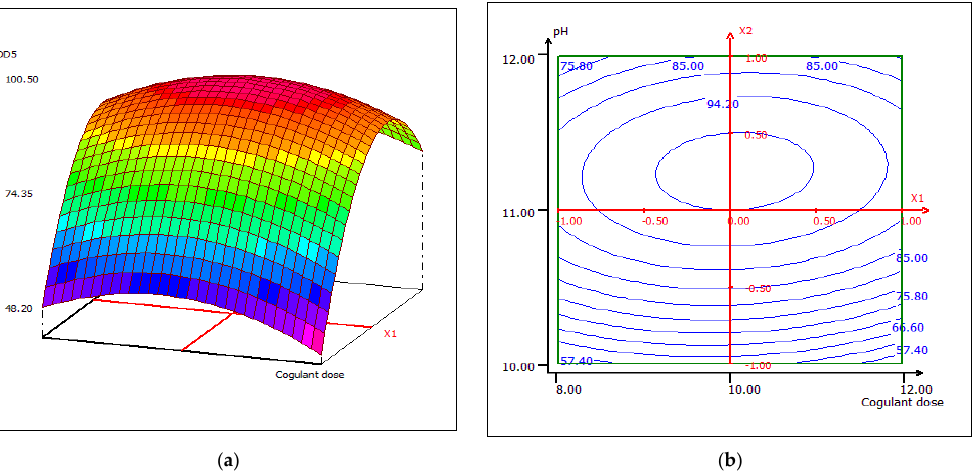
Figure 20. Three-dimensional ( a ) and two-dimensional ( b ) response surface plots for the BOD 5 of the treated food wastewater using β-chitin extract as a function of coagulant dose and pH, when the temperature was maintained at 23°C.